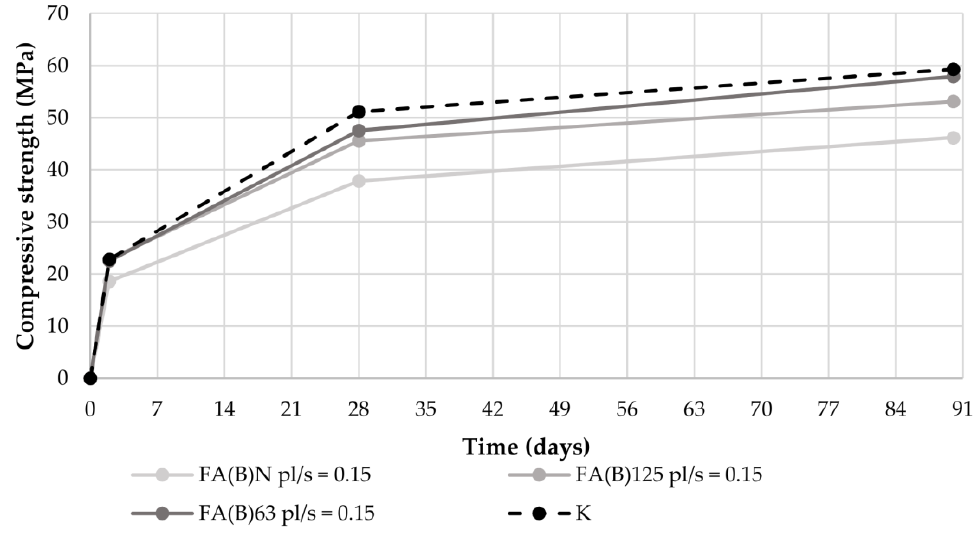
Figure 8. Strength development of mortars with 15% addition of sieved fly ash (FA(B)63 or FA(B)125) compared with the results of mortars with 15% addition of untreated fly ash (FA(B)N). The development of compressive strength of cement mortars modified with activated